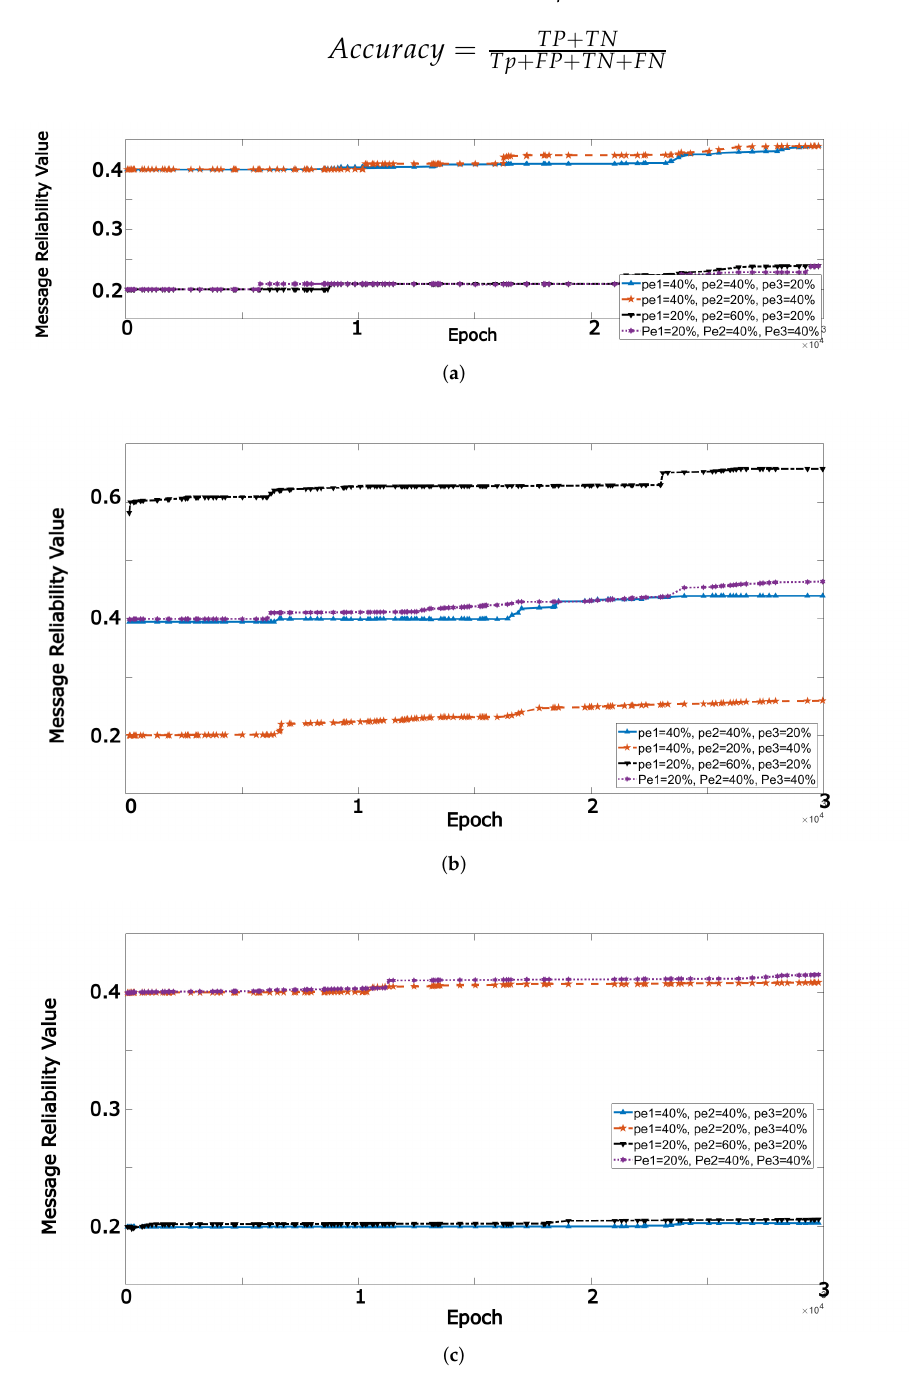
Figure 8. Message reliability values for different event rates. ( a ) Accident event; ( b ) Traffic event; ( c ) Road destruction